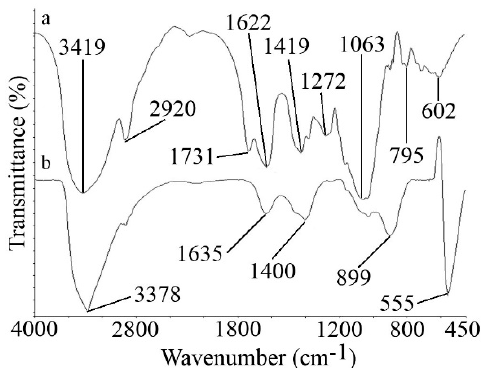
Figure 2. Fourier transform infrared spectroscopy (FTIR) spectra of ( a ) XG and ( b ) XG-capped ZnO microstars.